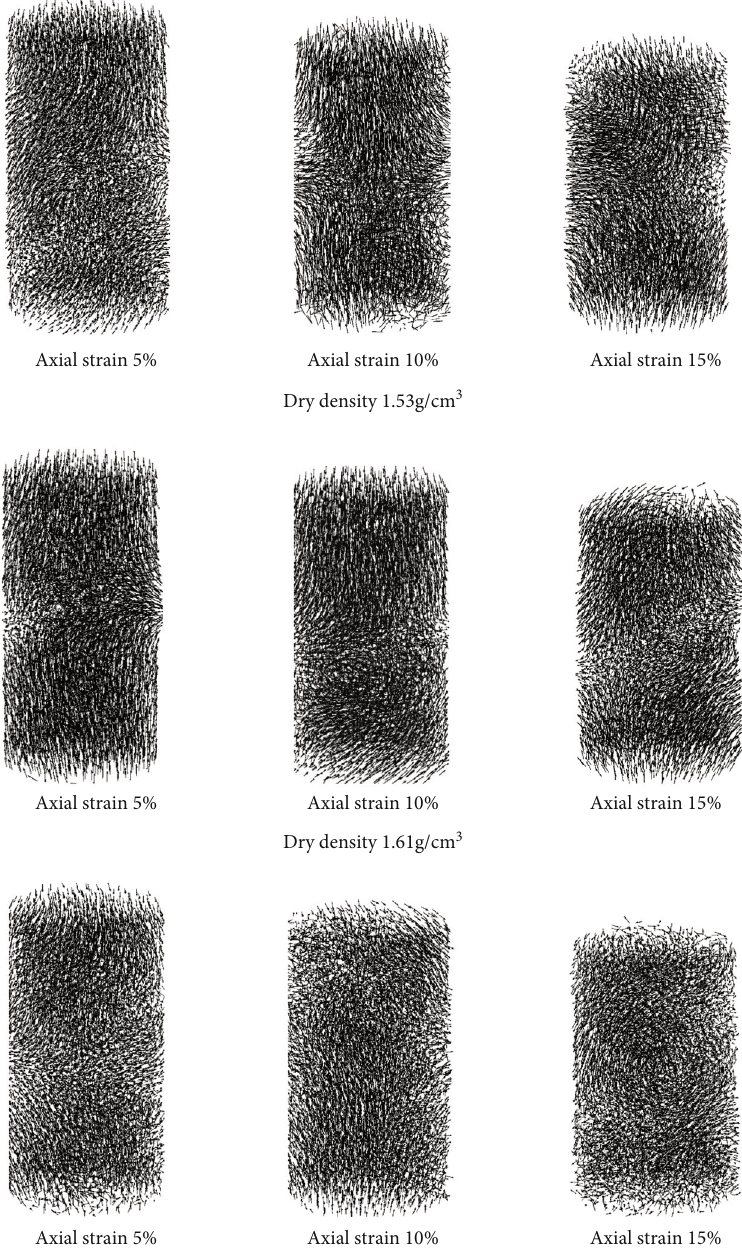
Figure 11: Velocity vector diagram of various axial strain sample under di ff erent dry